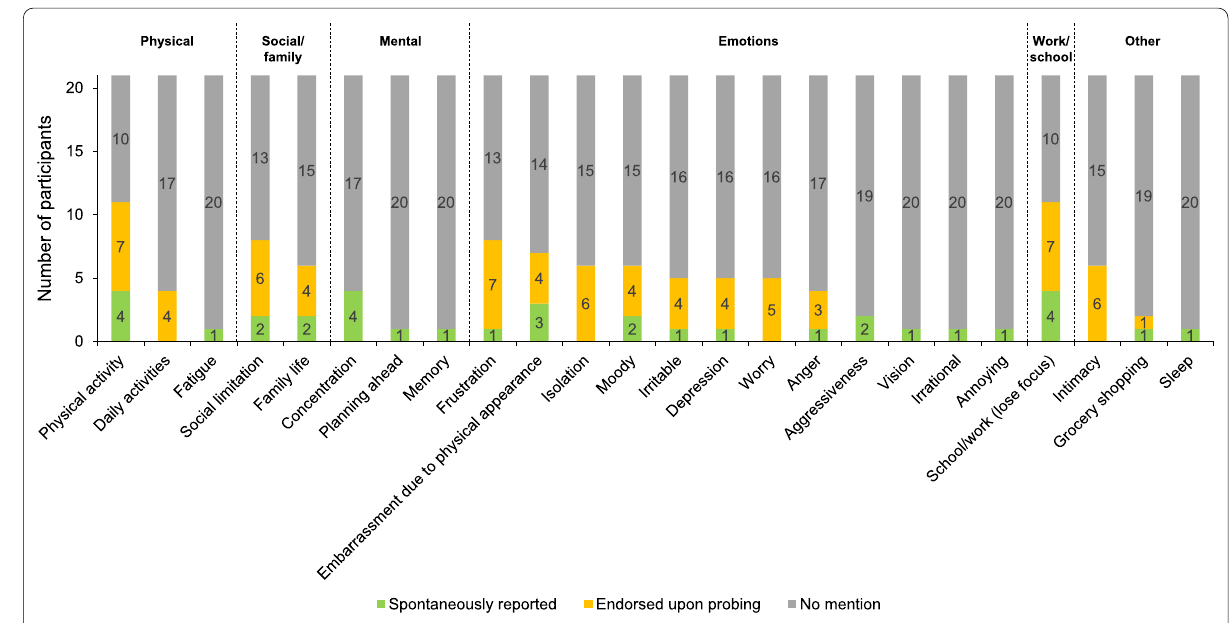
Fig. 4 Impacts of hunger‑related symptoms reported by study